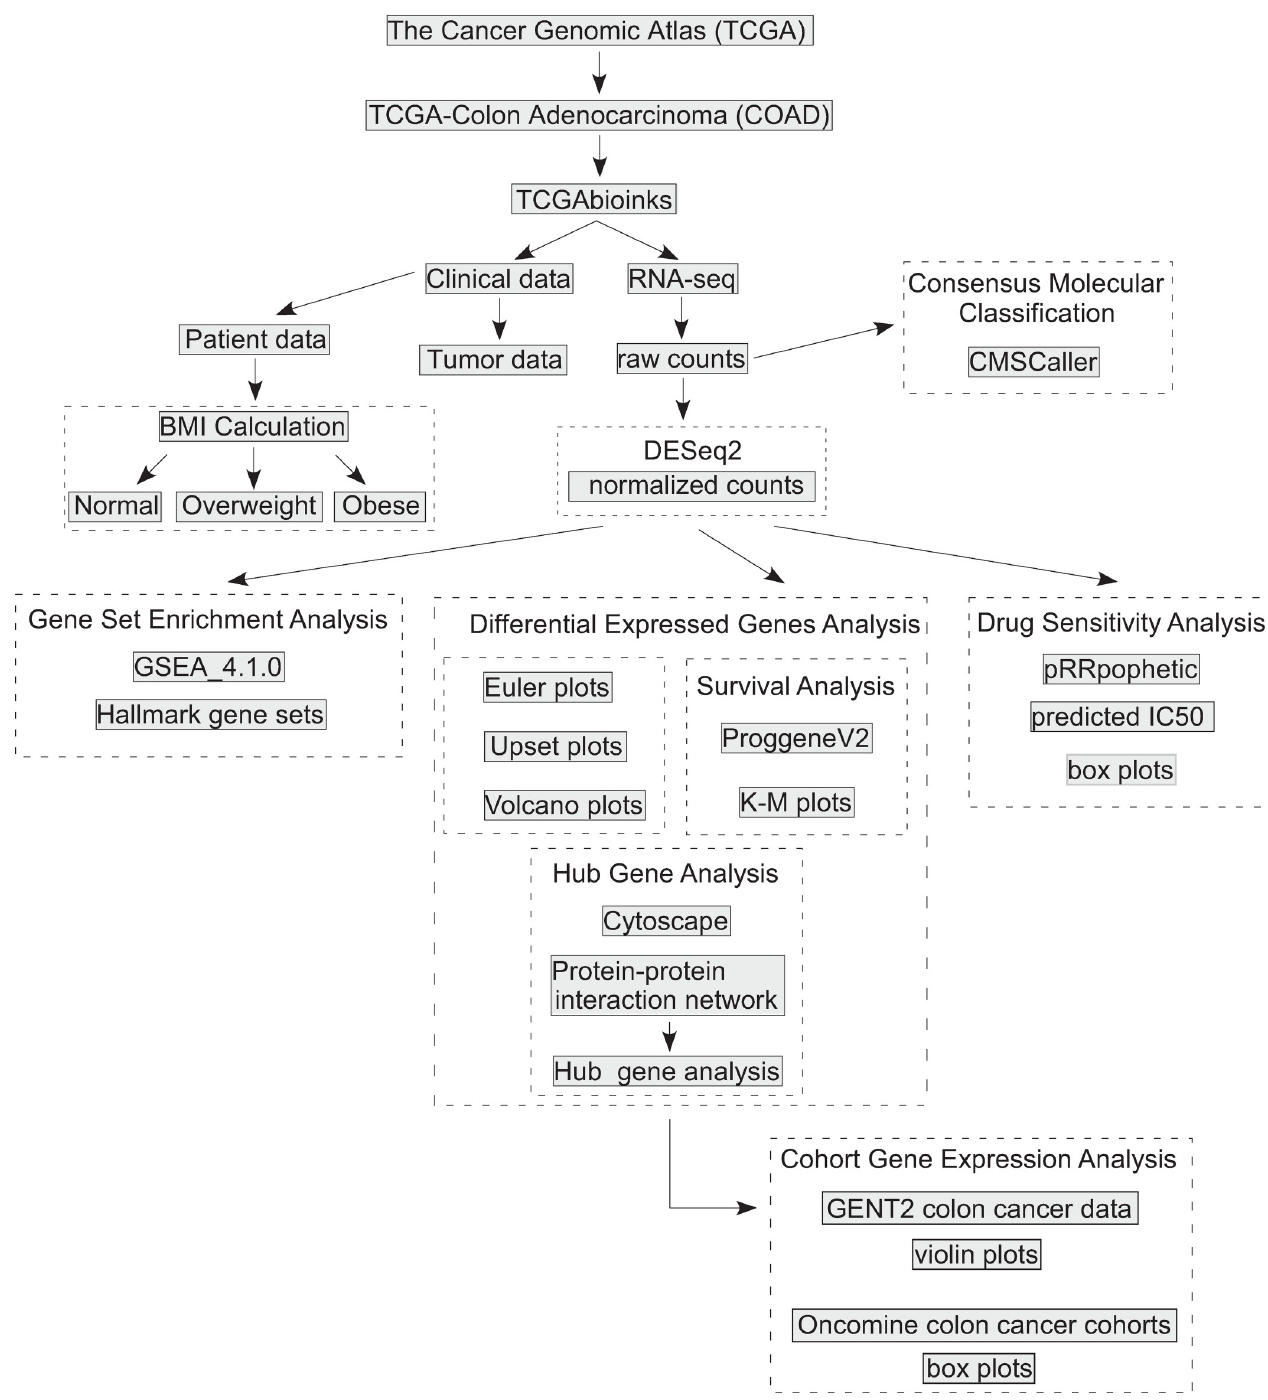
Fig 1. Transcriptomic analysis flow chart. Colon adenocarcinoma RNA-seq data (HT-Seq counts) and associated tumor and patient characteristics were obtained from The Cancer Genomic Atlas–Colon Adenocarcinoma (TCGA-COAD) database using the R package TCGAbiolinks. Body mass index (BMI) was calculated, and each patient was categorized as normal, overweight, and obese. Patient tumor samples from the TCGA-COAD were assigned to a consensus molecular subtype (CMS) using the R package CMScaller. Raw counts and associated phenotypes were inputted into DESeq2, and the following comparisons were made: obese vs. normal, obese vs. overweight, and overweight vs. normal for each CMS category. Volcano plots were generated using the R package EnhancedVolcano. Gene overlap between comparisons were visualized using Euler diagrams and upset plots from the R packages eulerr and UpsetR, respectively. To examine prognostic patient outcomes (Survival Analysis) DESeq2-obtained DEGs in the BMI comparisons for each CMS category was assessed using the PROGgeneV2 tool and Kaplan-Meier plots were generated to assess overall survival and relapse-free survival. Normalized RNA-seq counts obtained